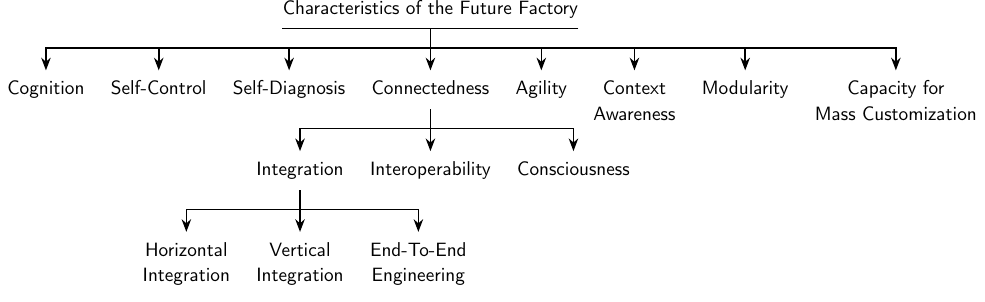
Figure 4. Characteristics of the Future